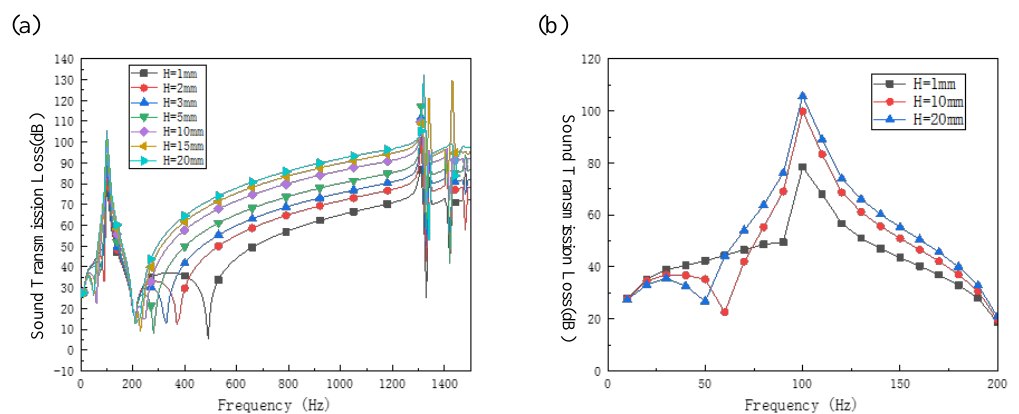
Figure 9. Effect of cavity thickness on STL for phononic crystals plate thickness of 10 mm: ( a ) 0 – 1500 Hz and ( b ) 0 – 200 Hz.